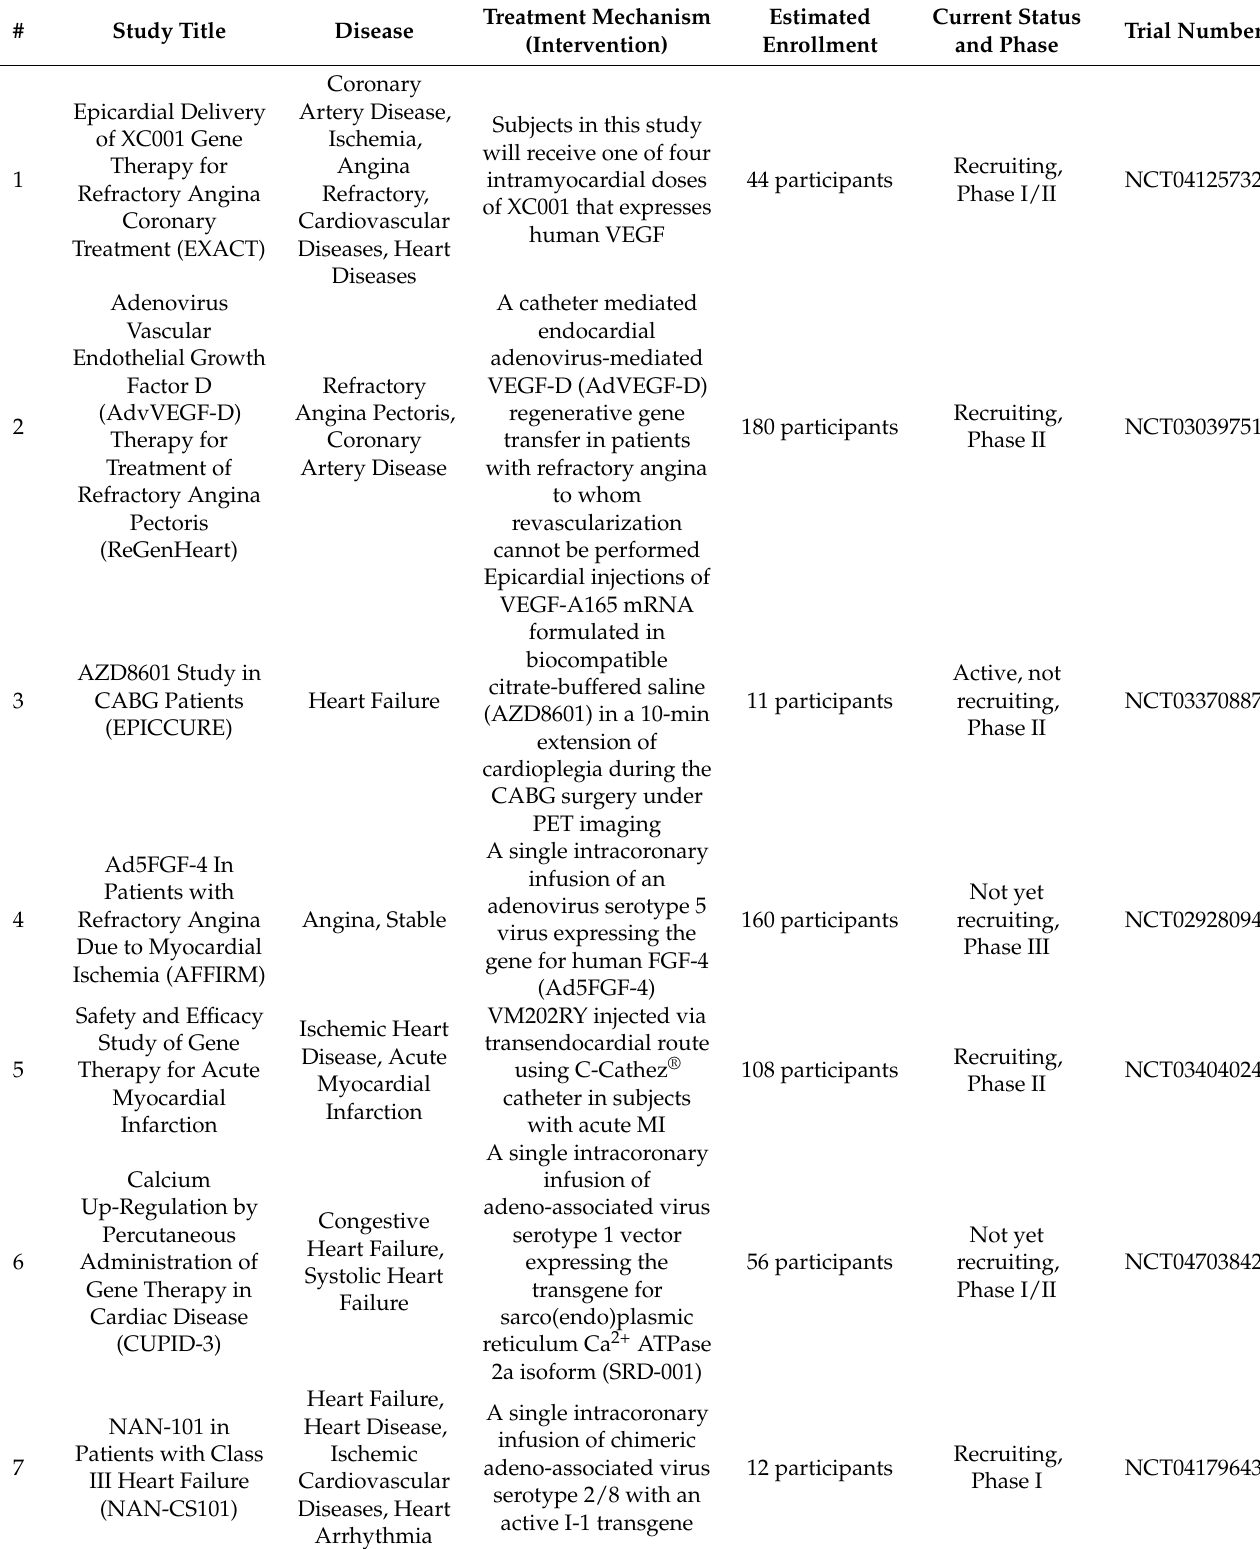
Table 1. Ongoing clinical trials in gene therapy for cardiac tissue regeneration in